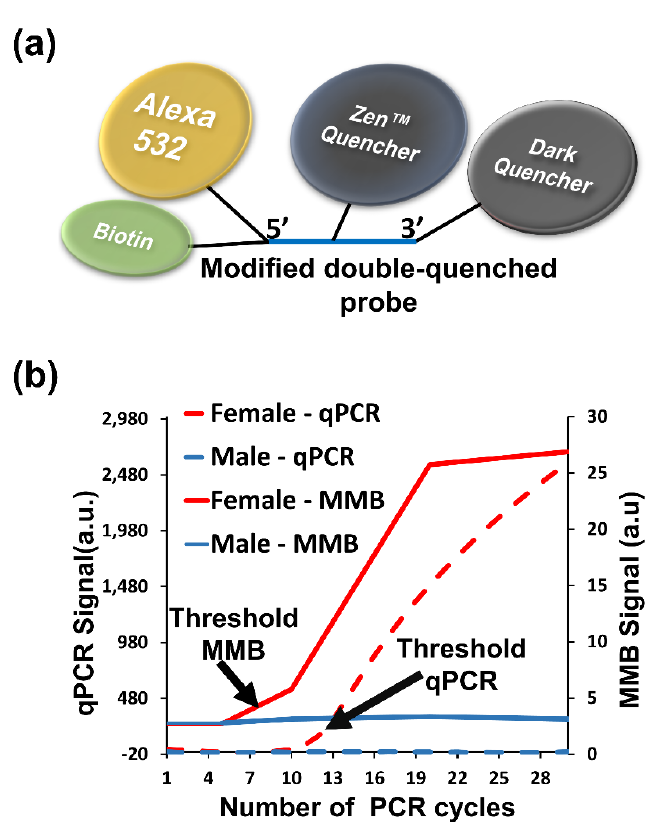
Figure 11. ( a ) Schematic of a modified double-quenched probe. ( b ) Comparative signal strengths in chick sexing experiments fusing the MMB system and qPCR. Using MMB, the sex of the hatchling could be determined after ~13 min, compared to 1 – 2 h using qPCR. Reprinted from [59], Copyright © 2019 American Chemical Society. Further permissions related to the material excerpted should be directed to ACS.